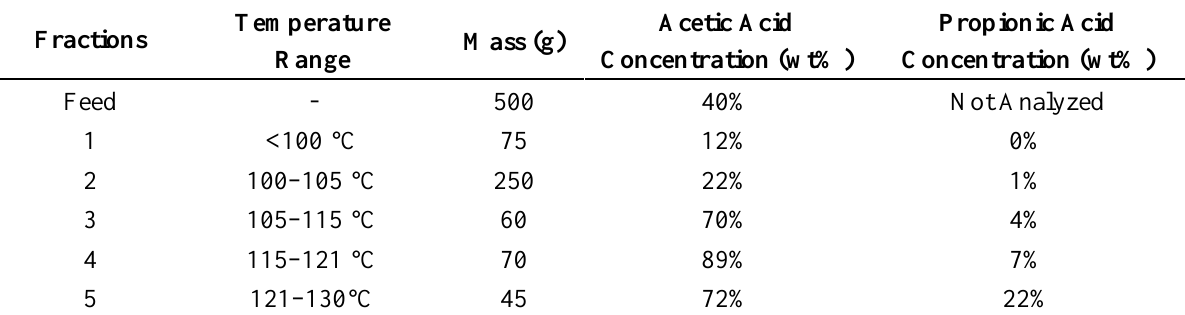
Table 2. Acetic and propionic acid concentrations in various 1st step distillation fractions produced from Table 1 aqueous